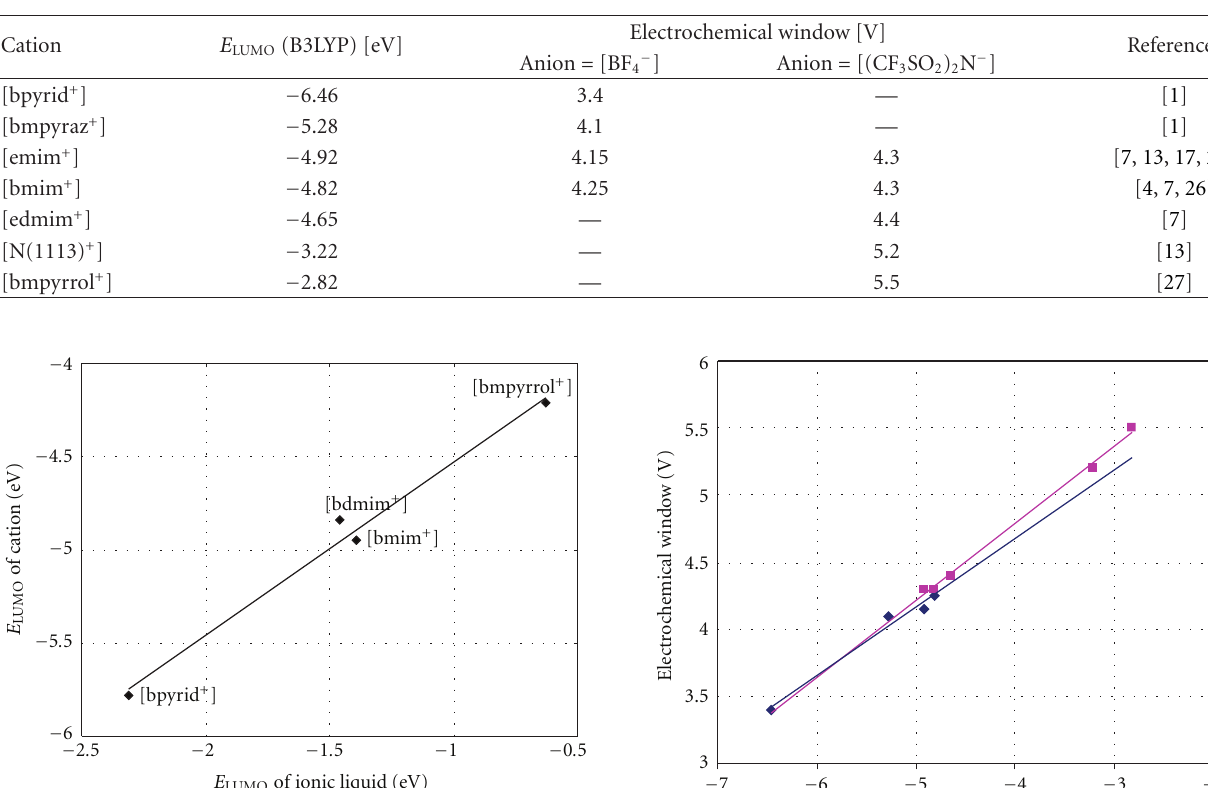
Figure 2: Structures of [bmim + ][BF 4 − ] and [bmim + ] cation, showing the electrostatic potential projected on the van der Waals surface (surface = electron density of 0.002 e/au 3 , property = electrostatic potential) and the position of the LUMO on [bmim + ][BF 4 − ] and on the cation [bmim + ] only. Red and blue in the orbitals refer to the phase only, and not to charge. Table 3: Calculated LUMO energy (B3LYP) of the cation of several ionic liquids with the same anion and their experimentally determined electrochemical windows.